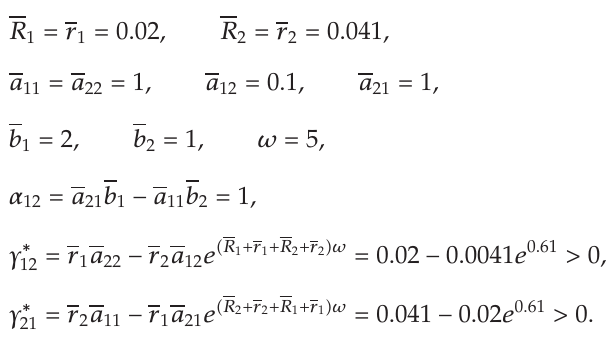
(cid:5) t (cid:6) , x ∗ (cid:5) t (cid:6) , red lines stand for x ∗∗ 2 1